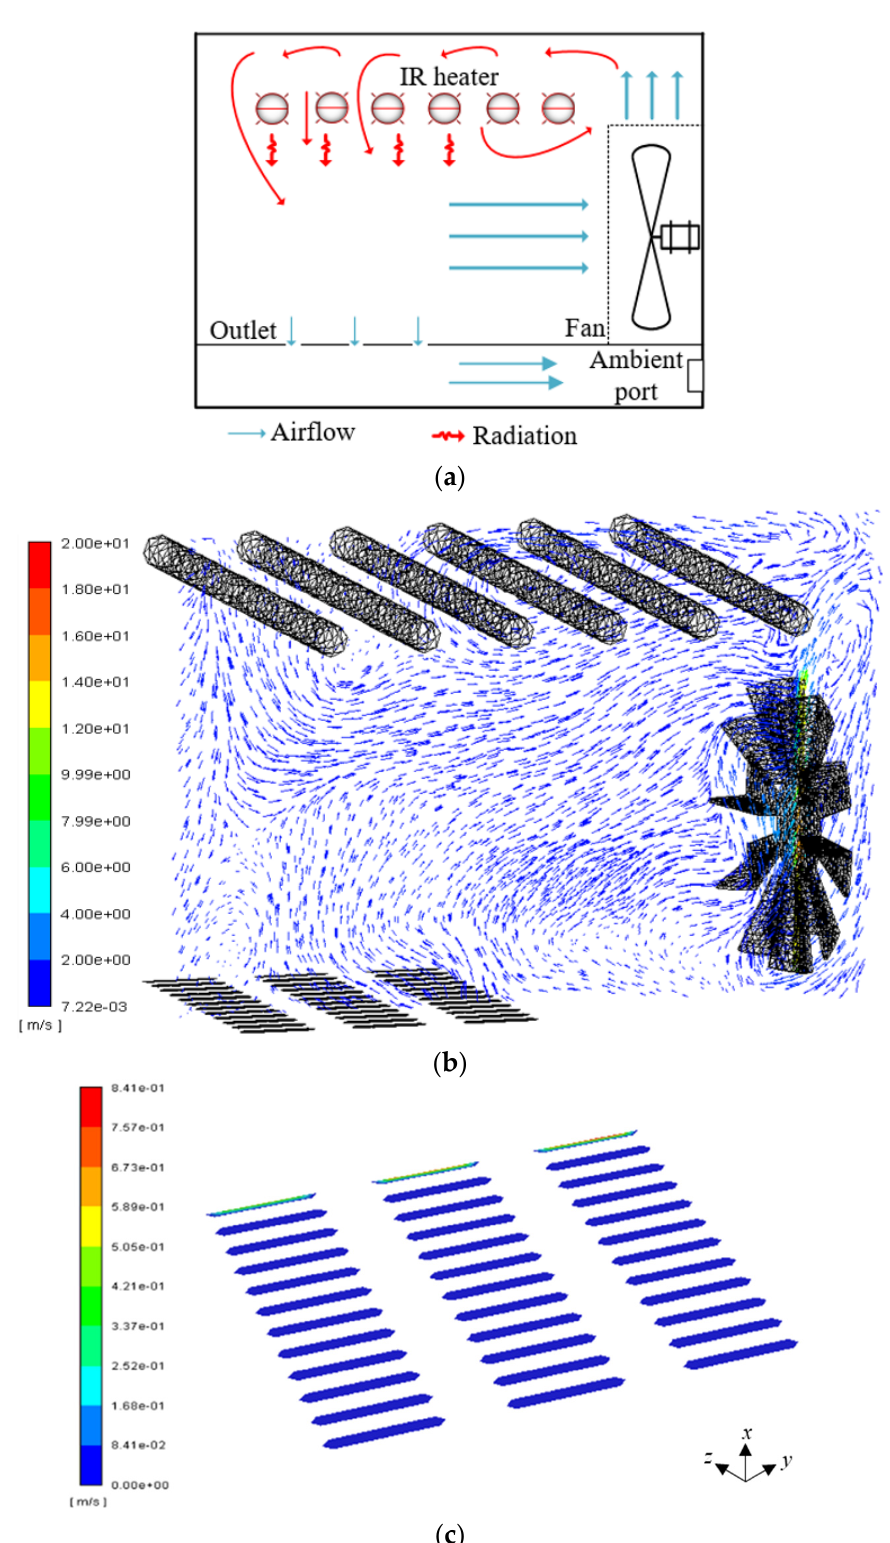
Figure 10. ( a ) Flow mechanism, ( b ) velocity vector and ( c ) zoomed outlet region in the oven.